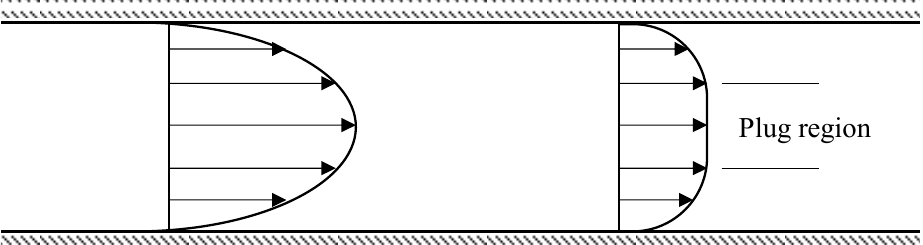
Figure 17. Flow profile between a Newtonian fluid and non-Newtonian fluid.